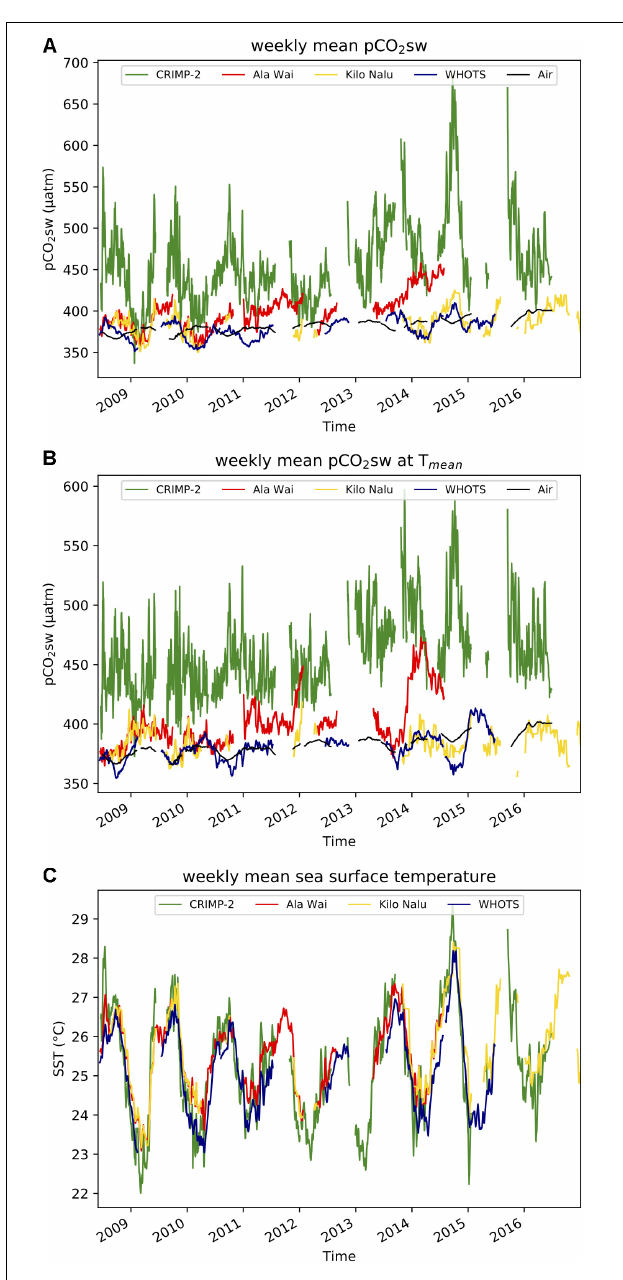
FIGURE 3 | Time-series of weekly mean values at CRIMP2, Ala Wai, Kilo Nalu, and WHOTS from June 2008 through December 2016. Weekly mean air p CO 2 is displayed in black. (A) p CO 2 sw. (B) p CO 2 sw normalized to the mean annual seawater temperature ( p CO 2 at T mean ). (C) Seawater temperature.